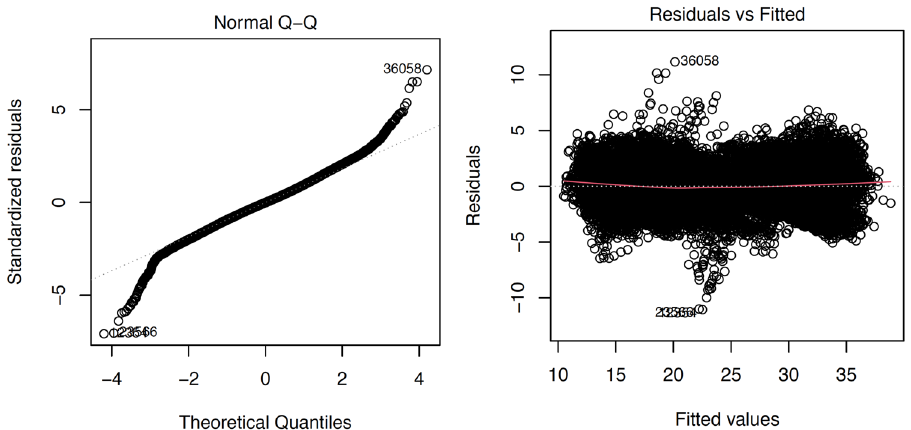
Figure 9. Linear regression diagnostic plots: (Left) QQ-plot (Right) residual plots.